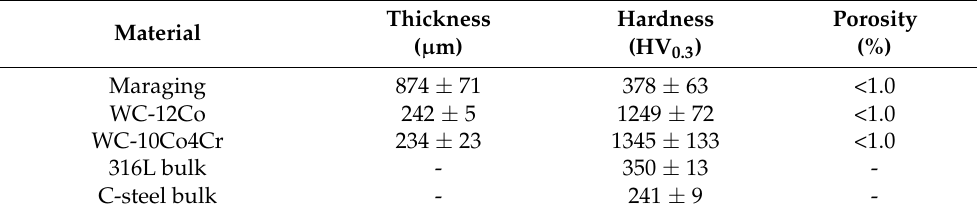
Table 3. Material characteristics and properties.